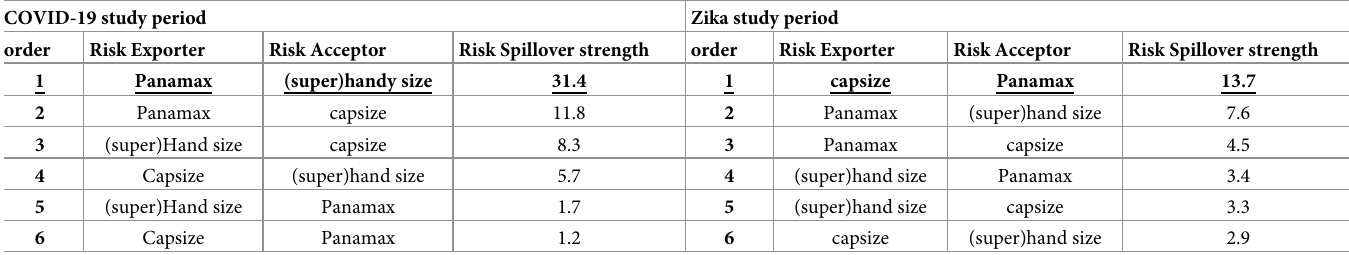
Table 13. Risk spillover intensity of two markets during public health